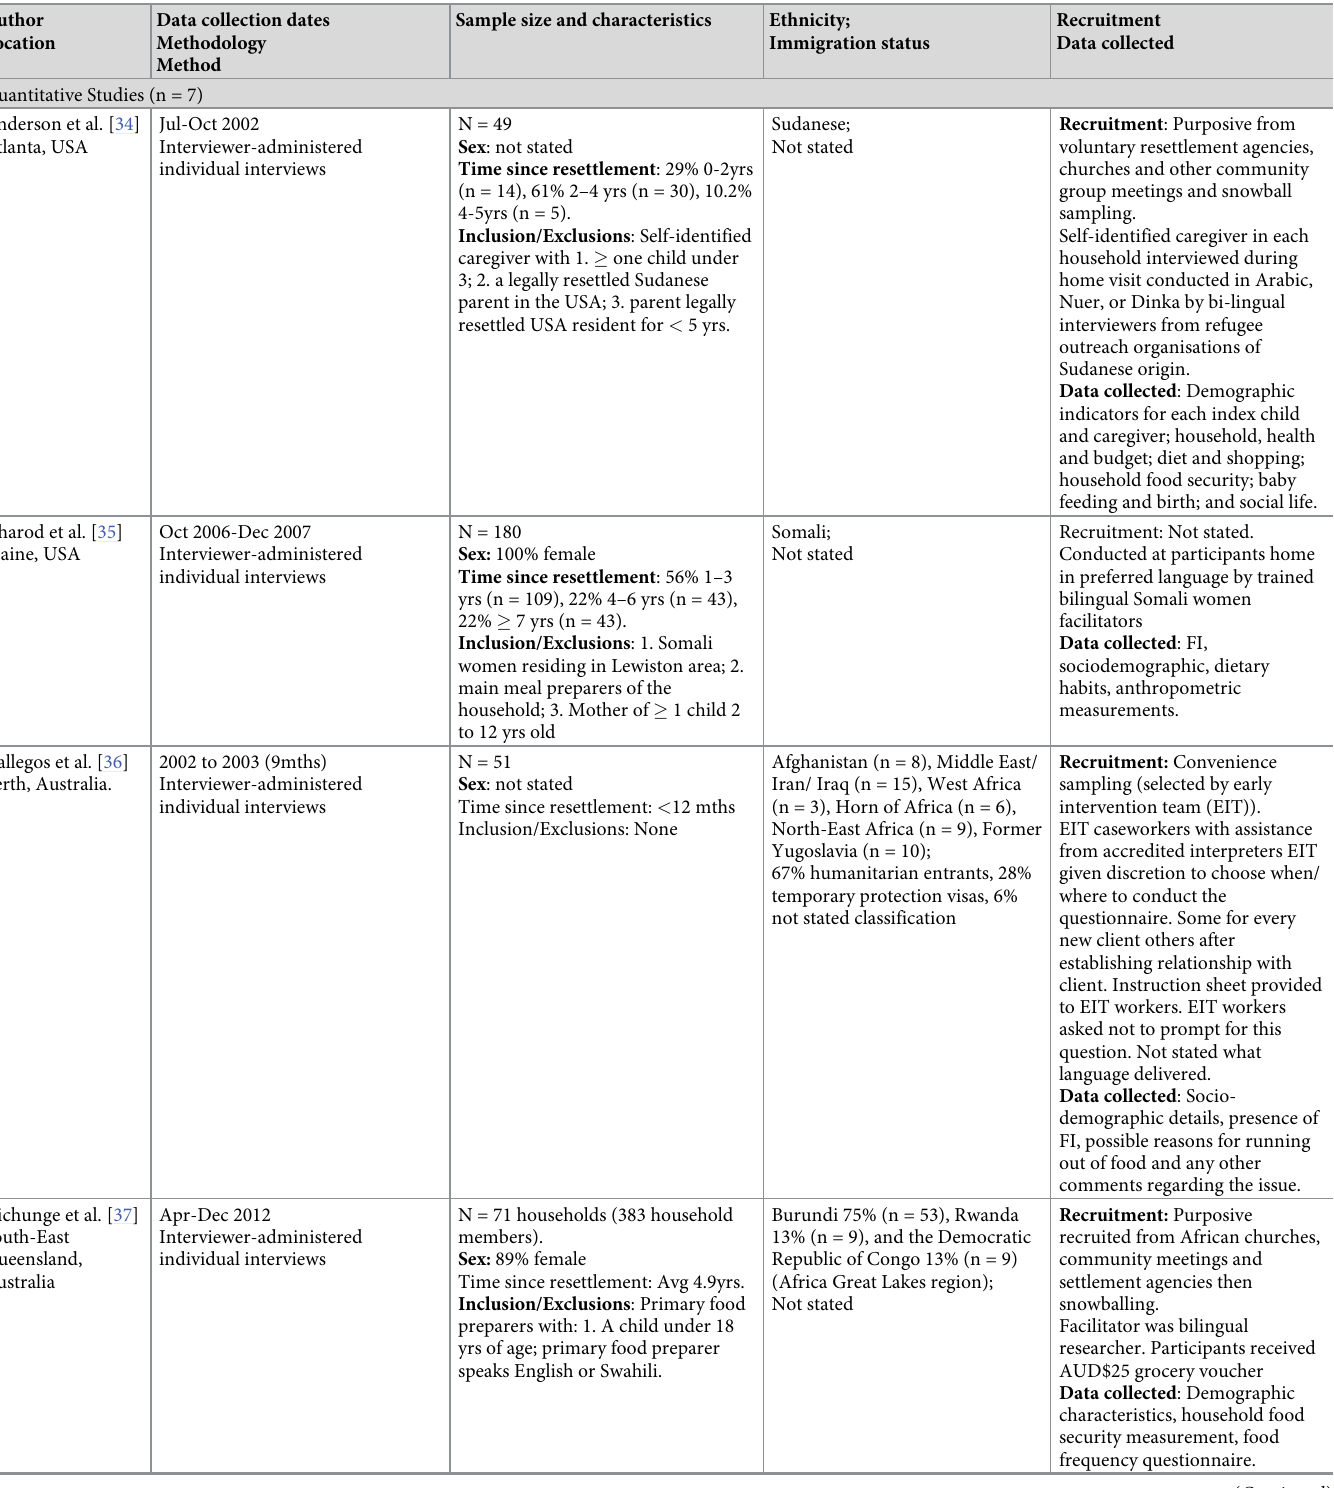
Table 1. Summary details of selected articles (n = 22) included in the systematic review and